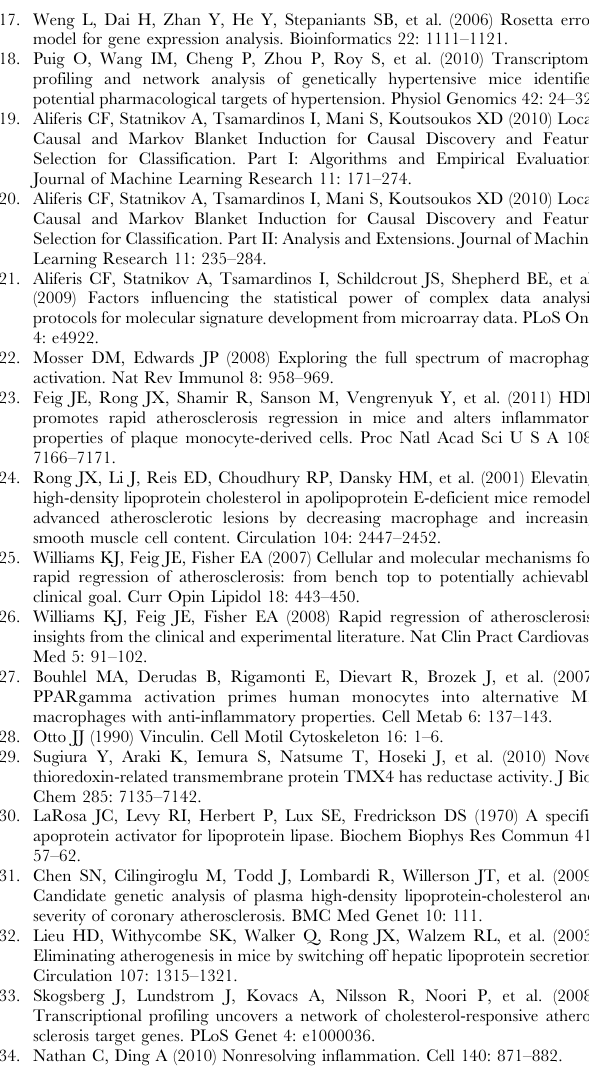
Table S1 qPCR assays used to confirm candidate genes. Table S2 The plaque regression differential profile. (XLS) Table S3 Biological processes enriched in up-regulated and down-regulated genes in the plaque regression signature.